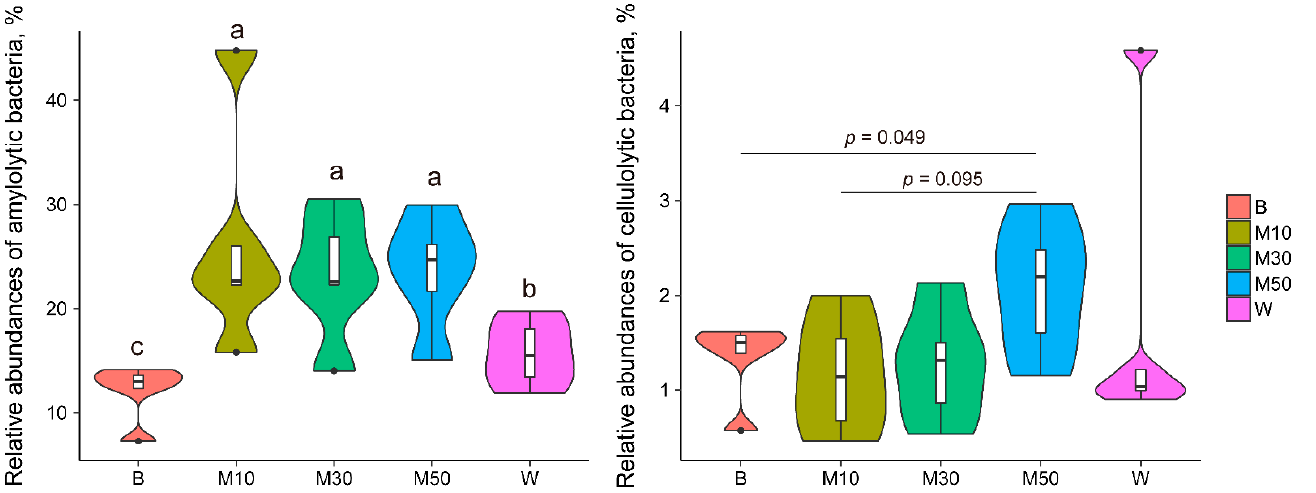
Figure 5. Dynamics of the amylolytic and cellulolytic bacteria following the monensin treatment in goats. Note: B, baseline period; M10, M30, and M50, on d 10, 30, and 50 of the treatment period; W, washout period. Different letters indicate significant difference between groups. Different lowercase letters between periods indicate a significant difference ( p < 0.05).